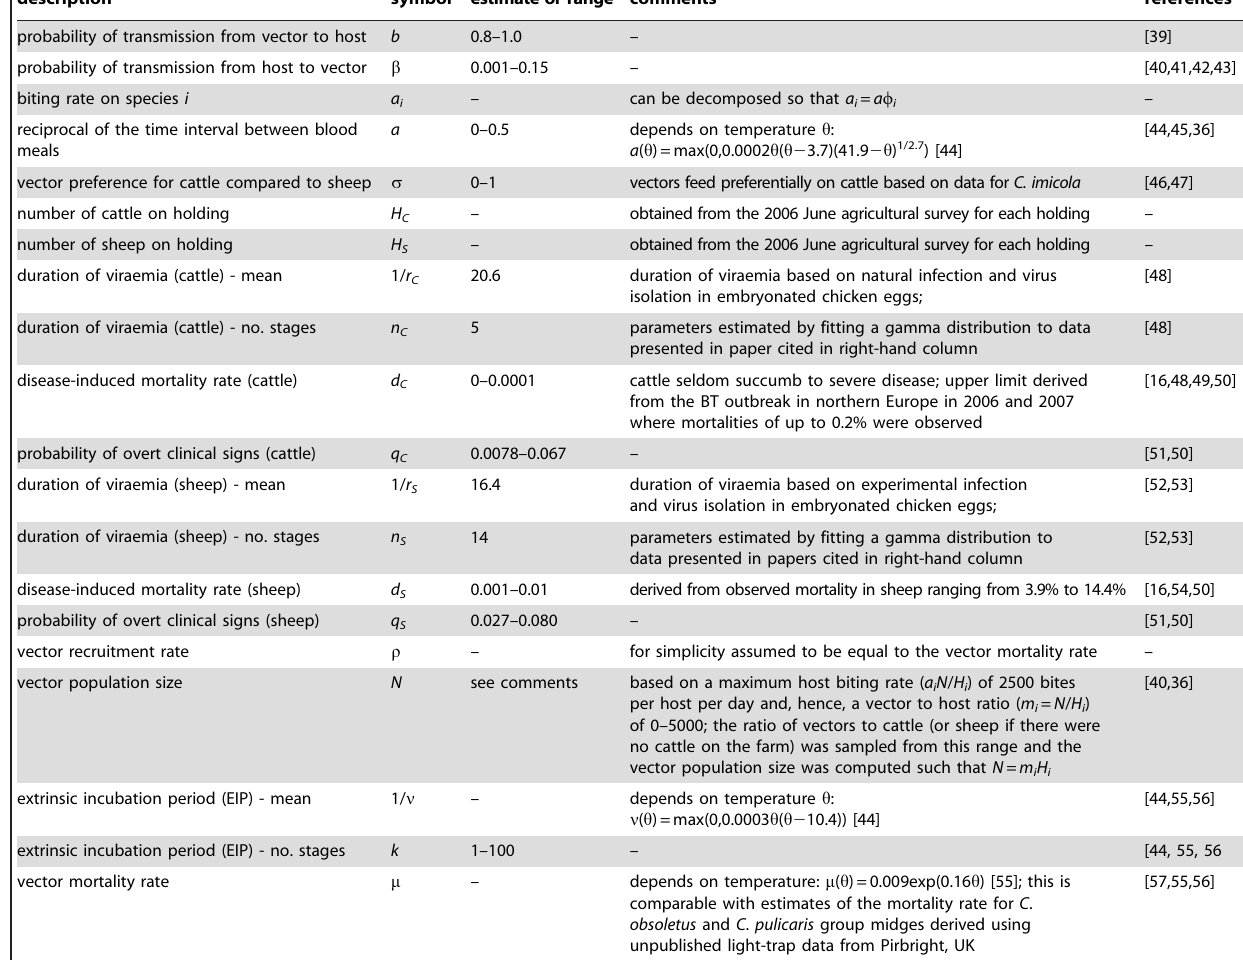
Table 2. Parameters in the model for the within-farm transmission of